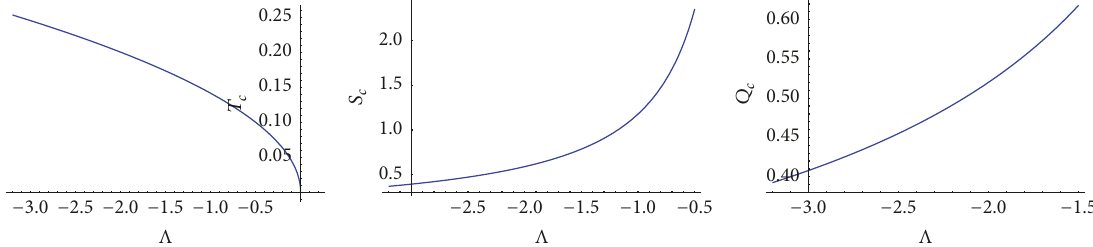
Figure 6: The figure shows the critical temperature 𝑇 𝑐 , the critical entropy 𝑆 𝑐 , and the critical charge 𝑄 𝑐 versus Λ for 𝛾 = −1 . Here 𝜆 = 1.2 .